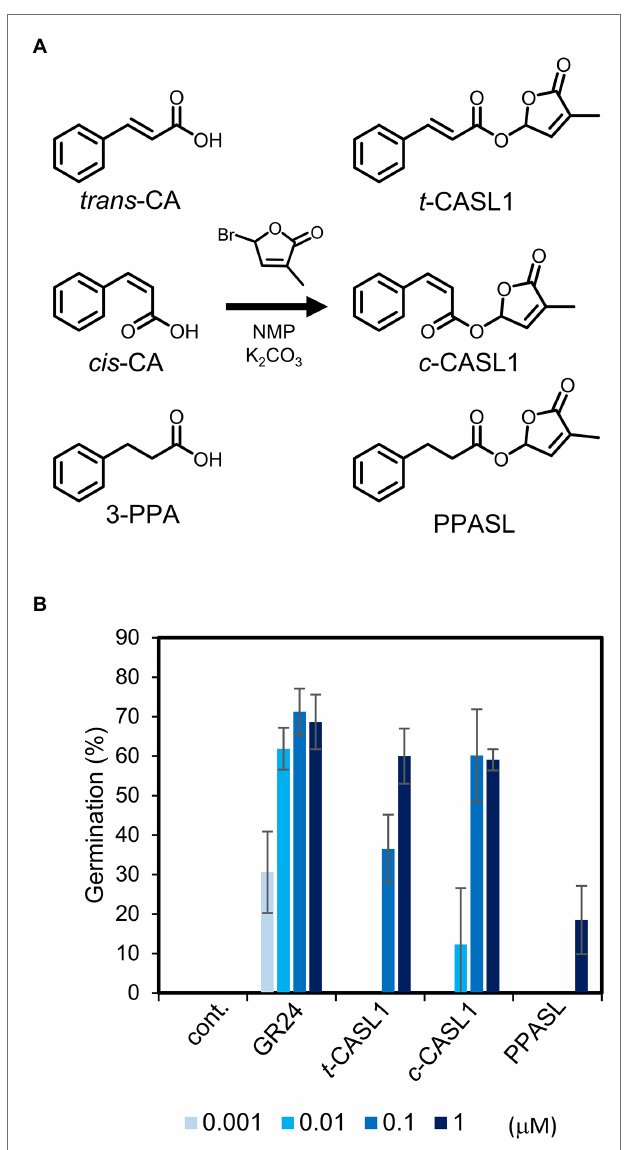
FIGURE 2 | Orobanche minor germination inducing activity of cinnamic acid (CA) derived SL analogs. (A) Synthetic scheme for the CA derived SL analogs. (B) Germination inducing activity of CASLs toward O. minor seeds. Data are the means ± SD ( n = 3). cont. means control with only acetone at